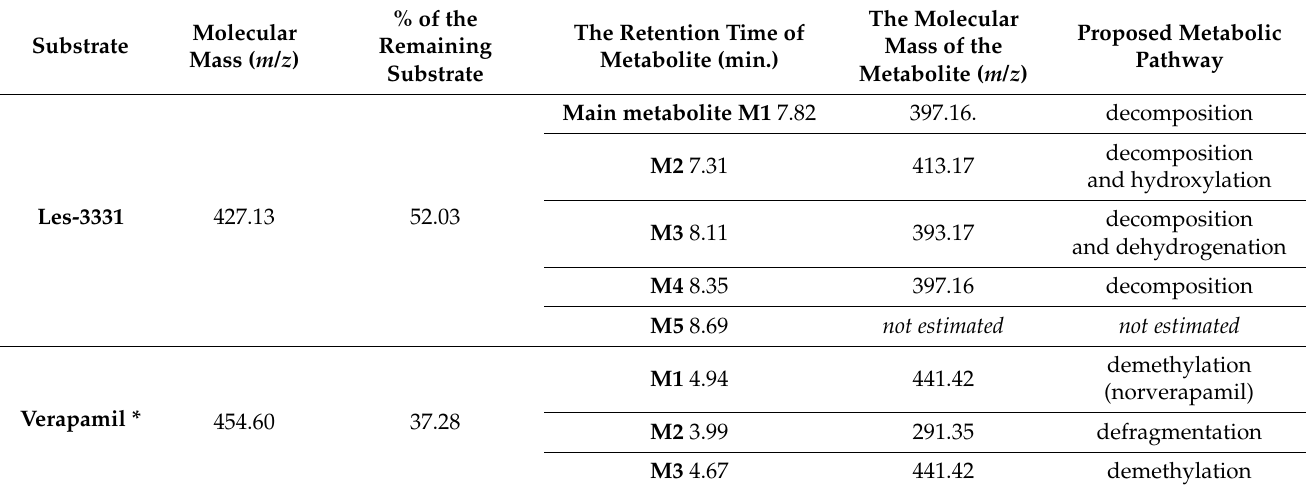
Figure 14. UPLC spectrum of the reaction mixture after 120 min incubation of Les-3331with RLMs. Table 2. The molecular masses of metabolites and proposed metabolic pathways of